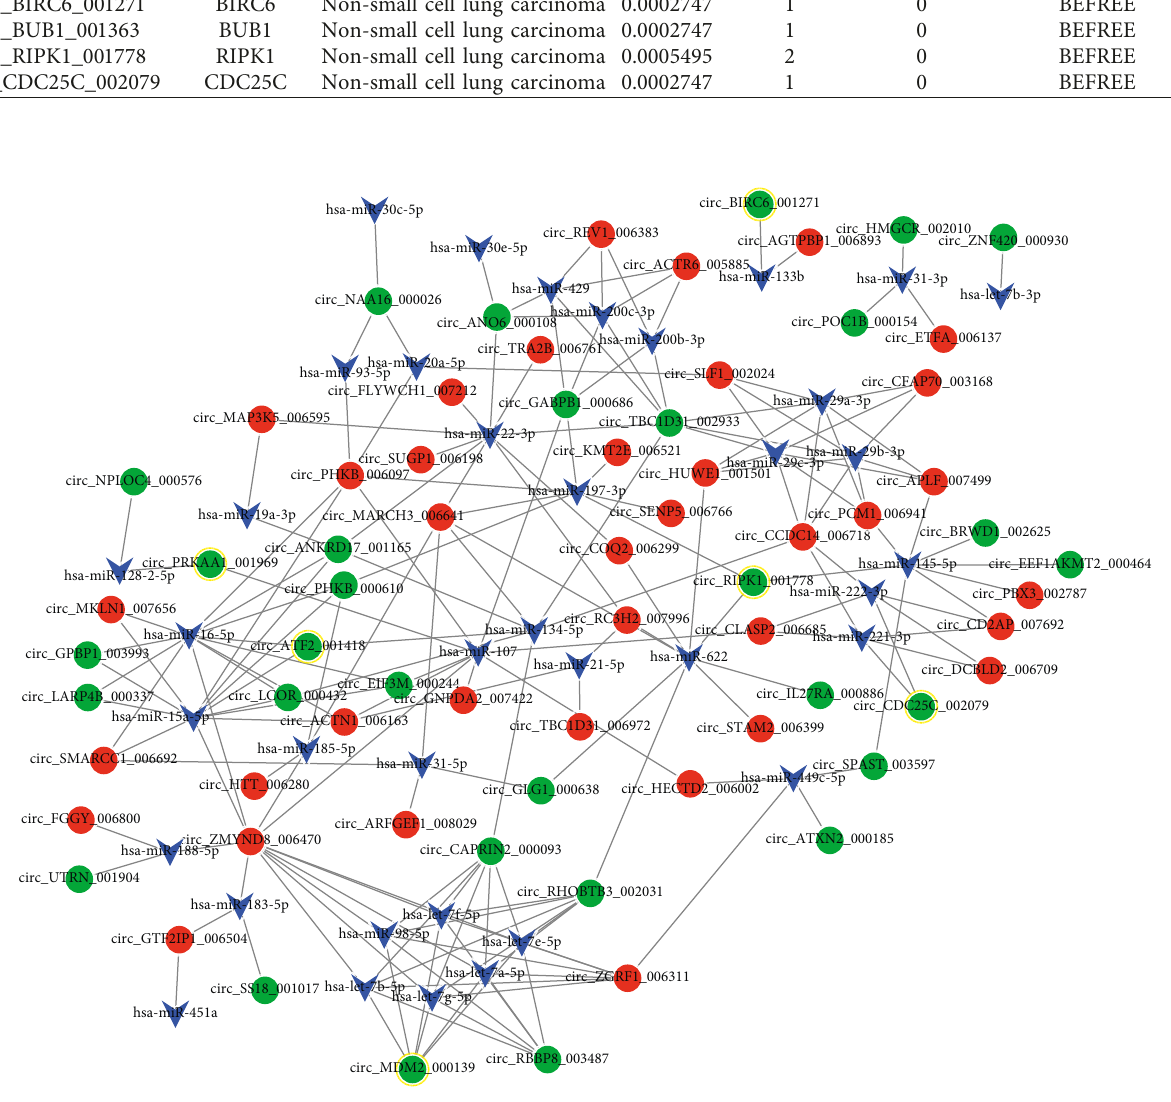
Figure 4: The miRNA-circular RNA (circRNA) regulatory network. Blue triangles, red circles, and green circles represent miRNAs, upregulated circRNAs, and downregulated circRNAs, respectively. The circles with yellow ring represent disease-associated